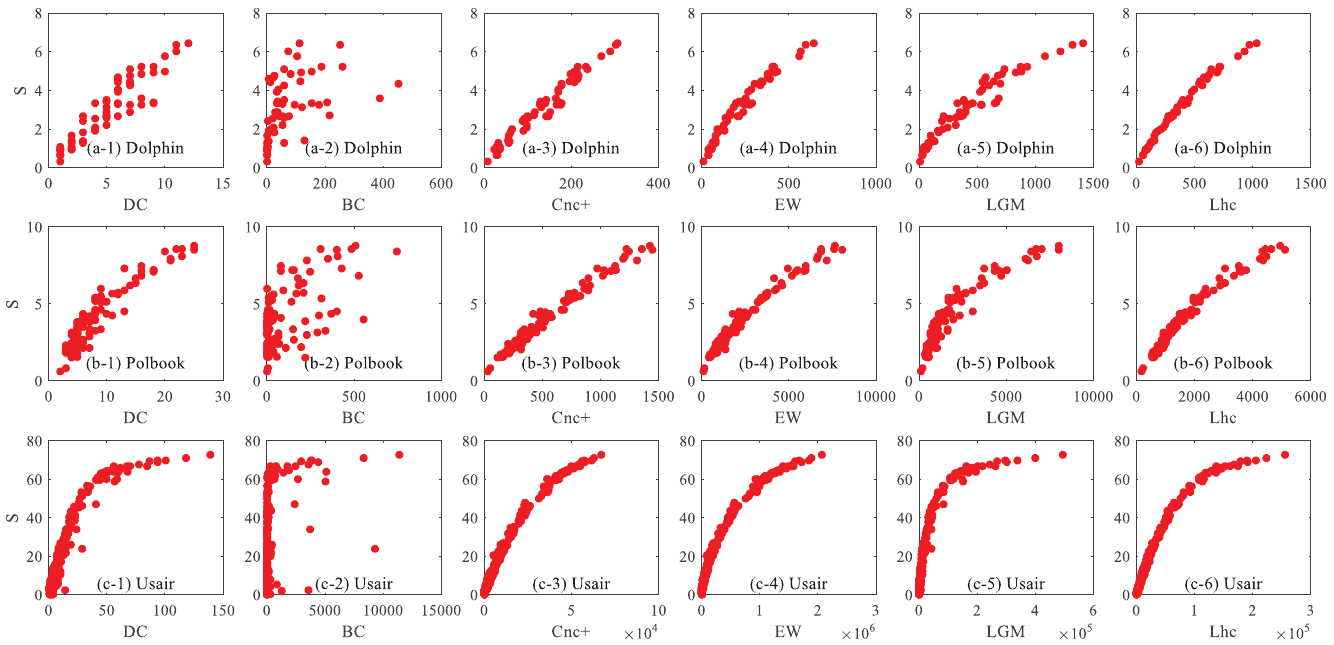
Fig 5. The relationship between node’s influence measured by the SIR model and six centrality measures. From top to bottom, (a), (b) and (c) correspond to the results on Dolphin, Polbook and Usair respectively. Each point indicates a node in the network, the x axis denotes the value of Spreading influence (denoted by S) and the y axis denotes the value of the six centralities respectively, including DC, BC, Cnc + , EW, LGM and Lhc.